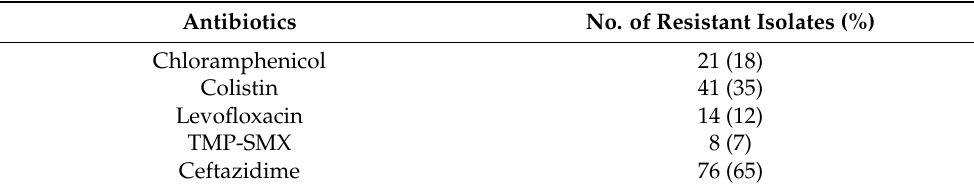
Table 2. Antibiotic-resistant profiles of 117 S . maltophilia isolates were obtained from the patients with